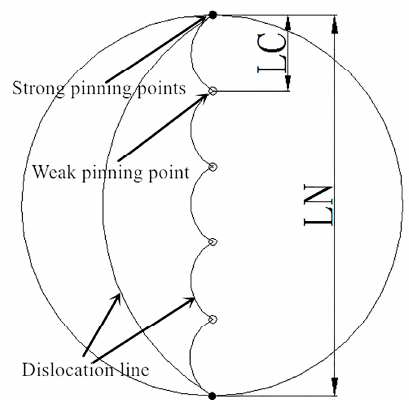
Figure 5. Granato-Lücke (G–L) model theory.